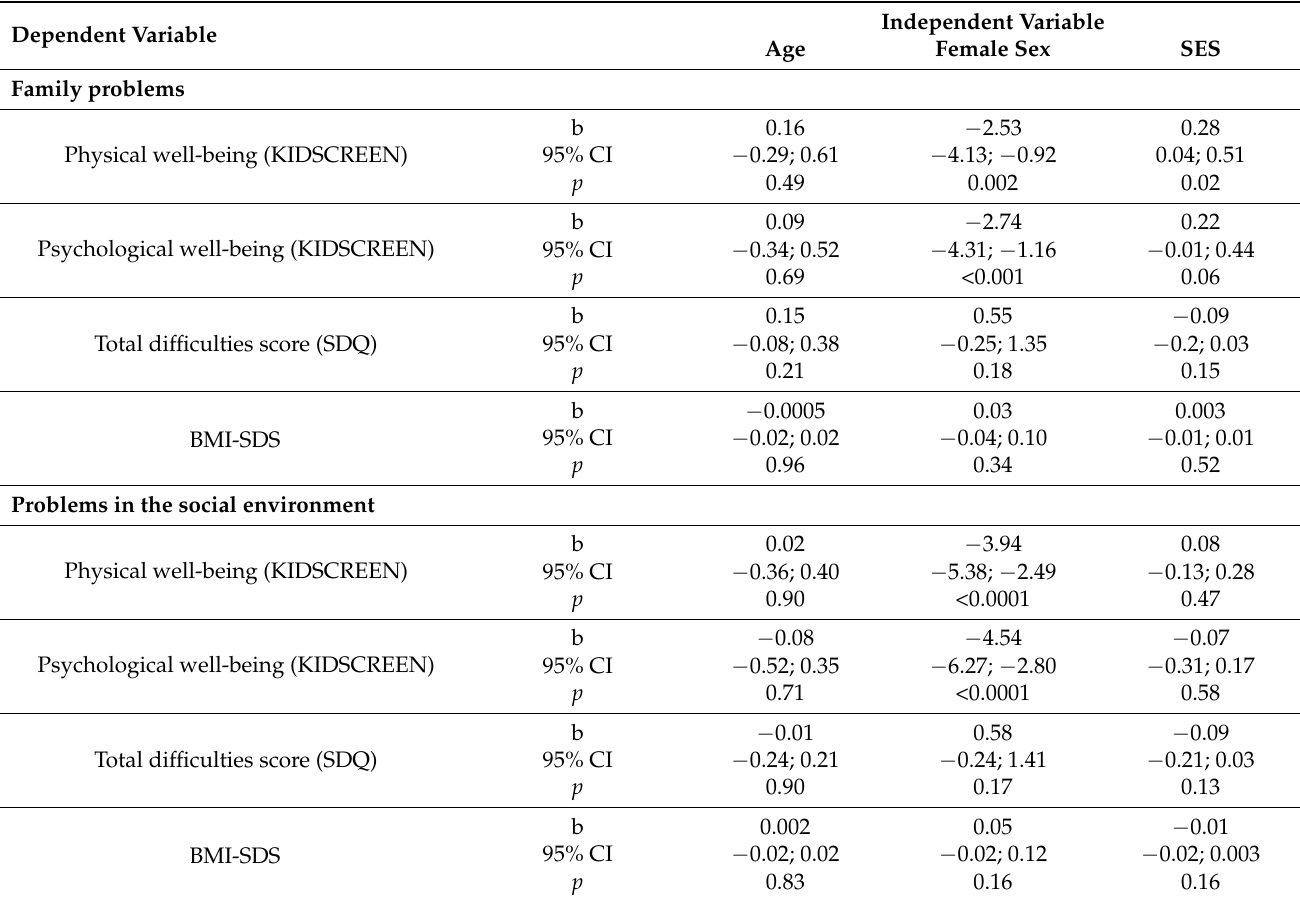
Table 3. Associations between age, sex, and SES and differences in health parameters from before to after an